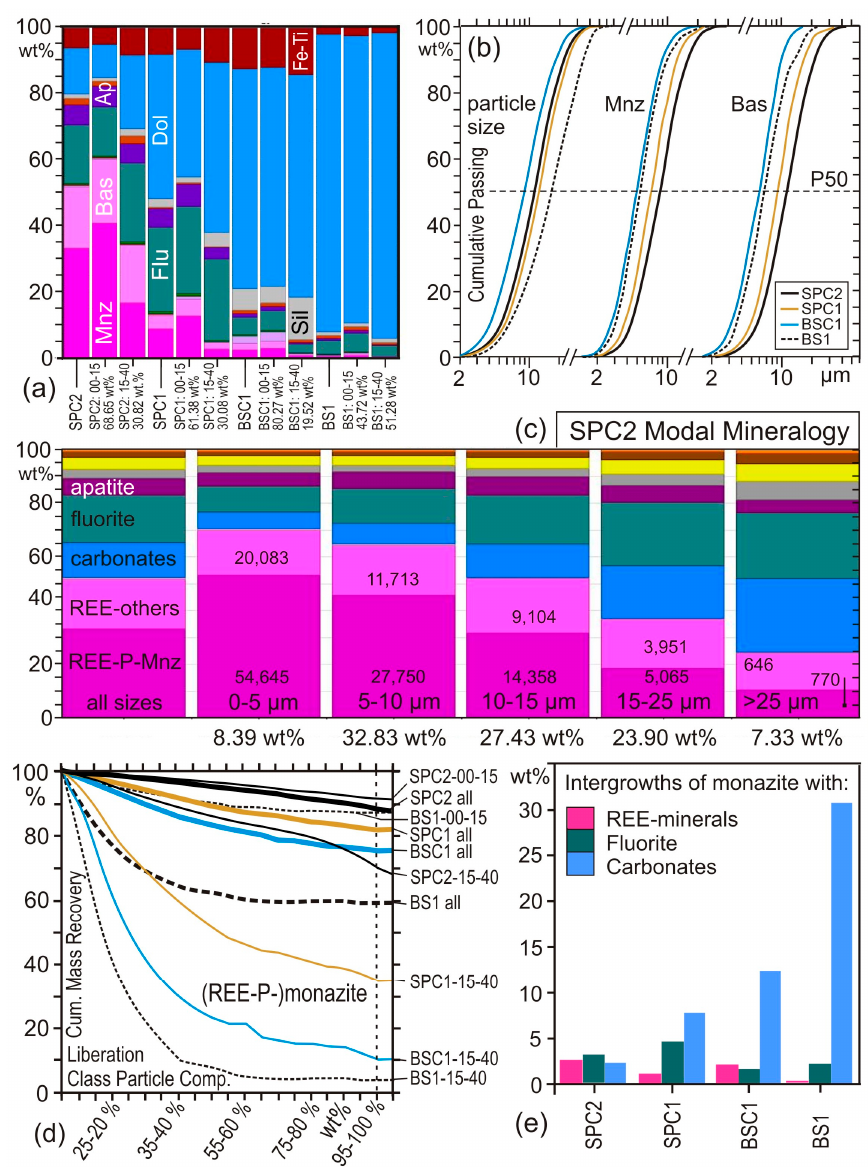
Figure 5. Results of mineral processing tests with the steps SPC2-SPC1-BSC1-BS1 during multistage flotation of REE carbonatite ore (see Figure 4 for positions of samples in the flow scheme. ( a ) Modal mineralogy (in wt %) of complete samples and selected particle size fractions after virtual sieving with the filter mode equivalent circle diameter. Ap—apatite; Bas—bastnaesite; Dol—dolomite; Fe-Ti—Fe-Ti-minerals; Flu—fluorite; Mnz—REE-P-monazite; Sil—silicate minerals. SPC2—second cleaner concentrate; SPC1—scavenger cleaner concentrate; BSC1—scavenger cleaner middlings; BS1—tailings. ( b ) Cumulative particle size distributions (cumulative passing) of the step samples of the mineral processing tests in (a), for all particles, for (REE-P)-monazite (Mnz) and bastnaesite (Bas). ( c ) Modal mineralogy of virtual sieve fractions of concentrate SPC2. Proportions of fractions are listed below the columns. Maximum modes of REE minerals are found in the fraction 0–5 µ m. Numbers are grain counts. ( d ) Mineral liberation of (REE-P)-monazite in terms of proportion in wt % of particle composition. Data for complete samples (labelled as all) in thick lines; data for selected particle size classes in microns after virtual sieving in thin lines. Same legend as in (b). ( e ) Intergrowth relationships of non-liberated (REE-P)-monazite with other REE-minerals, fluorite and carbonates.